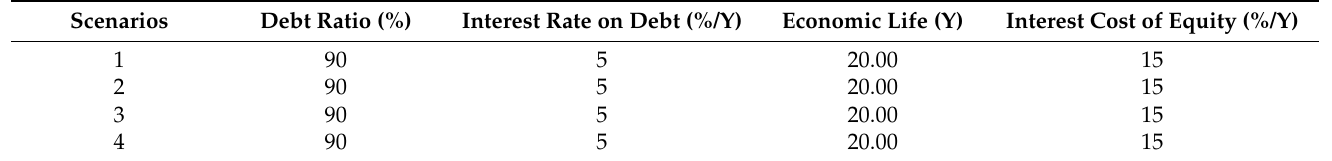
Table A7. Model variable inputs: